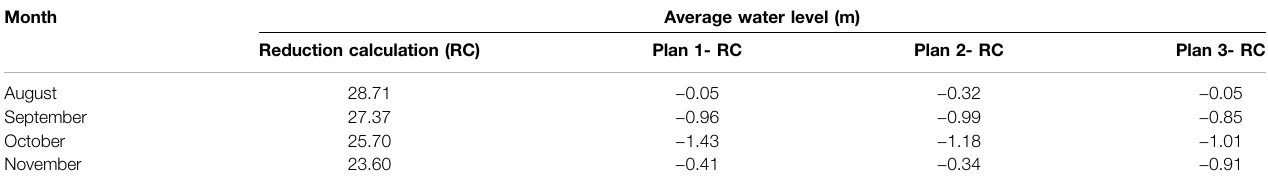
TABLE 6 | Variation of average water level by month at Chenglingji station with different impoundment